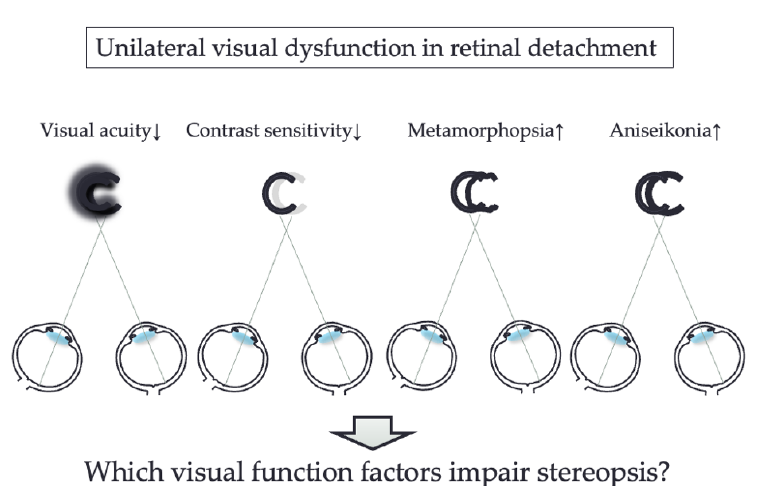
Figure 1. Conceptual illustration of the effect of impairment of visual function factors in one eye on stereopsis.